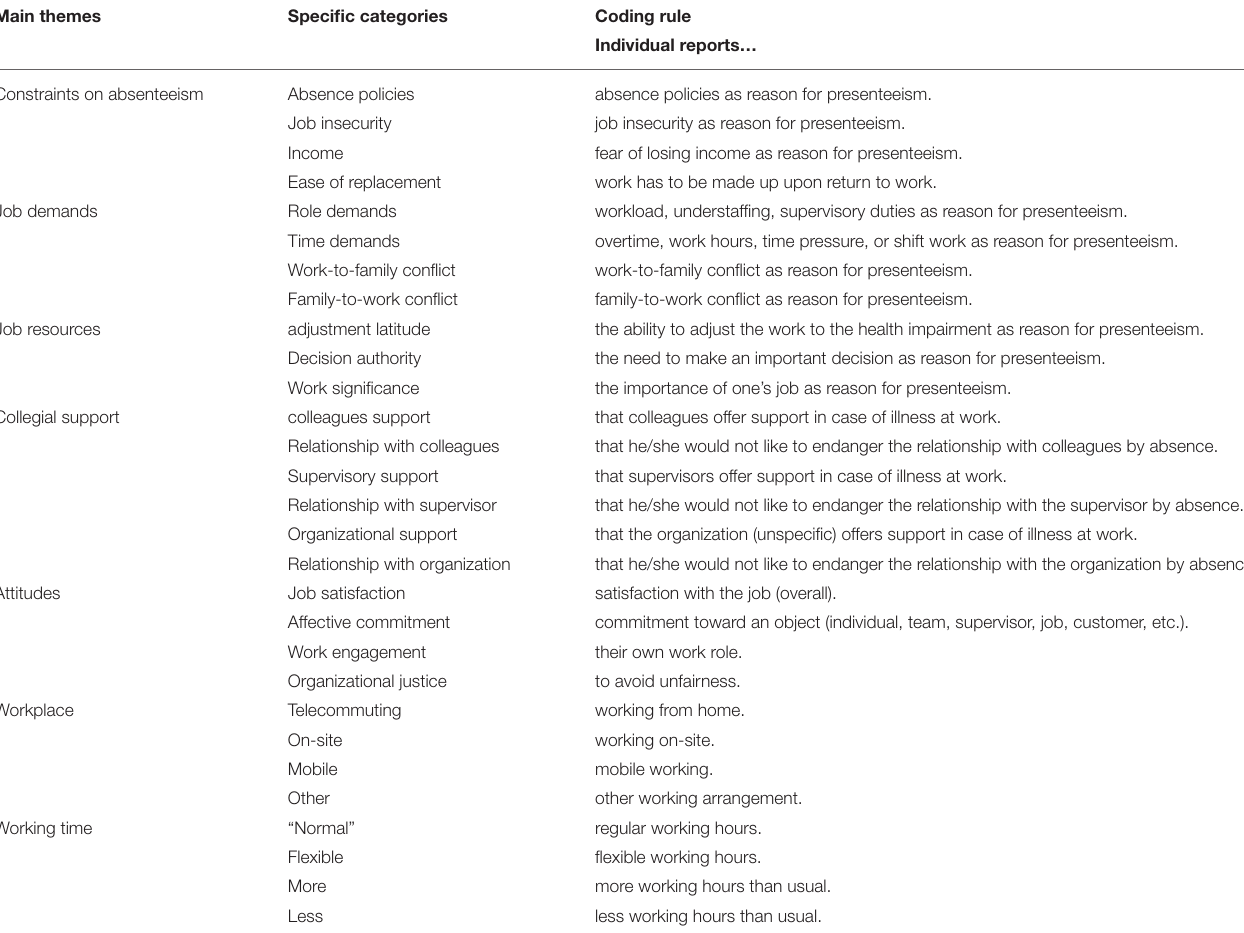
TABLE 1 | Themes, specific categories, and coding rules for deductive